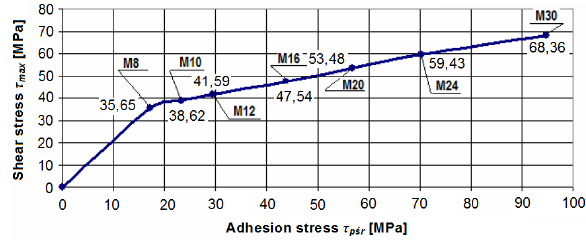
Figure 7: Dependency shear stress – edge stress for M8 ÷ M30 anchors in the gable wall.